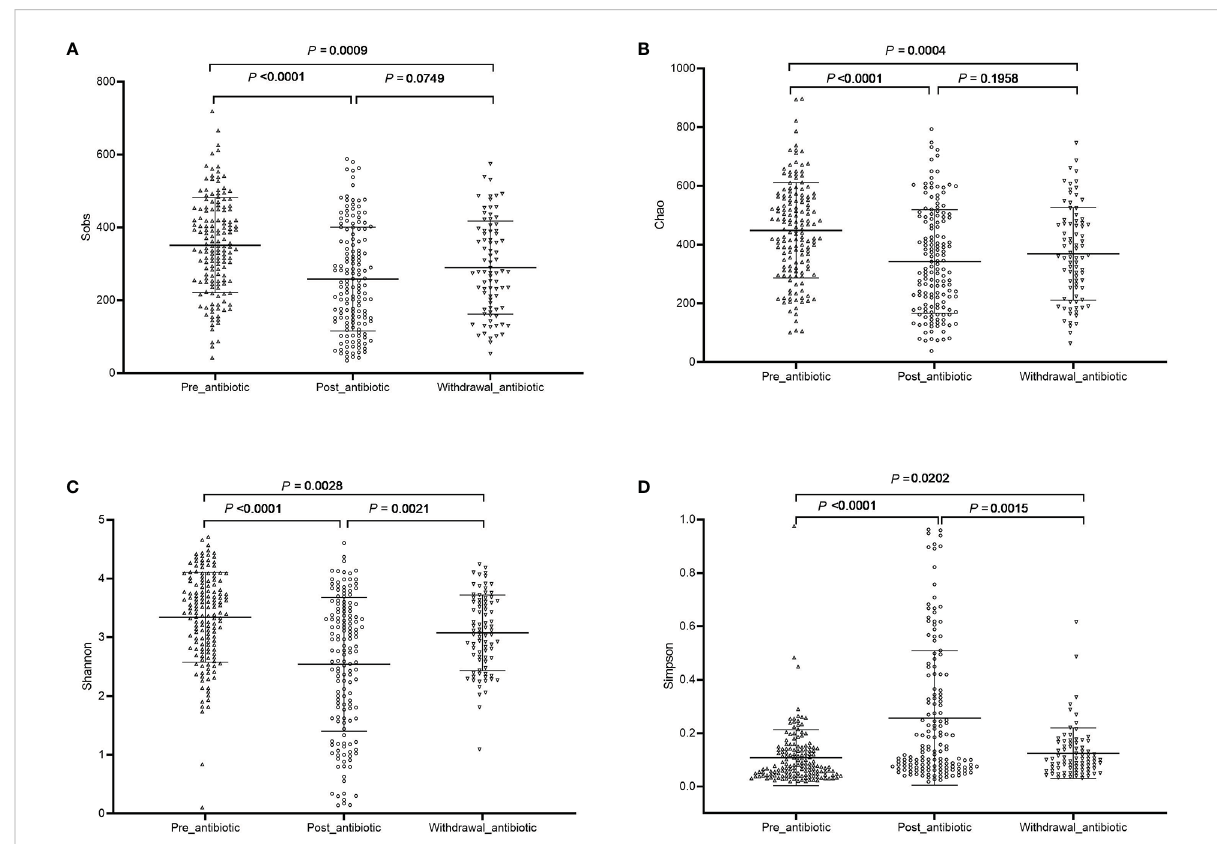
FIGURE 1 The community richness and diversity of each group of gut microbiota in the antibiotics group. (A) : Sobs index; (B) : Chao index; (C) : Shannon index; (D) : Simpson